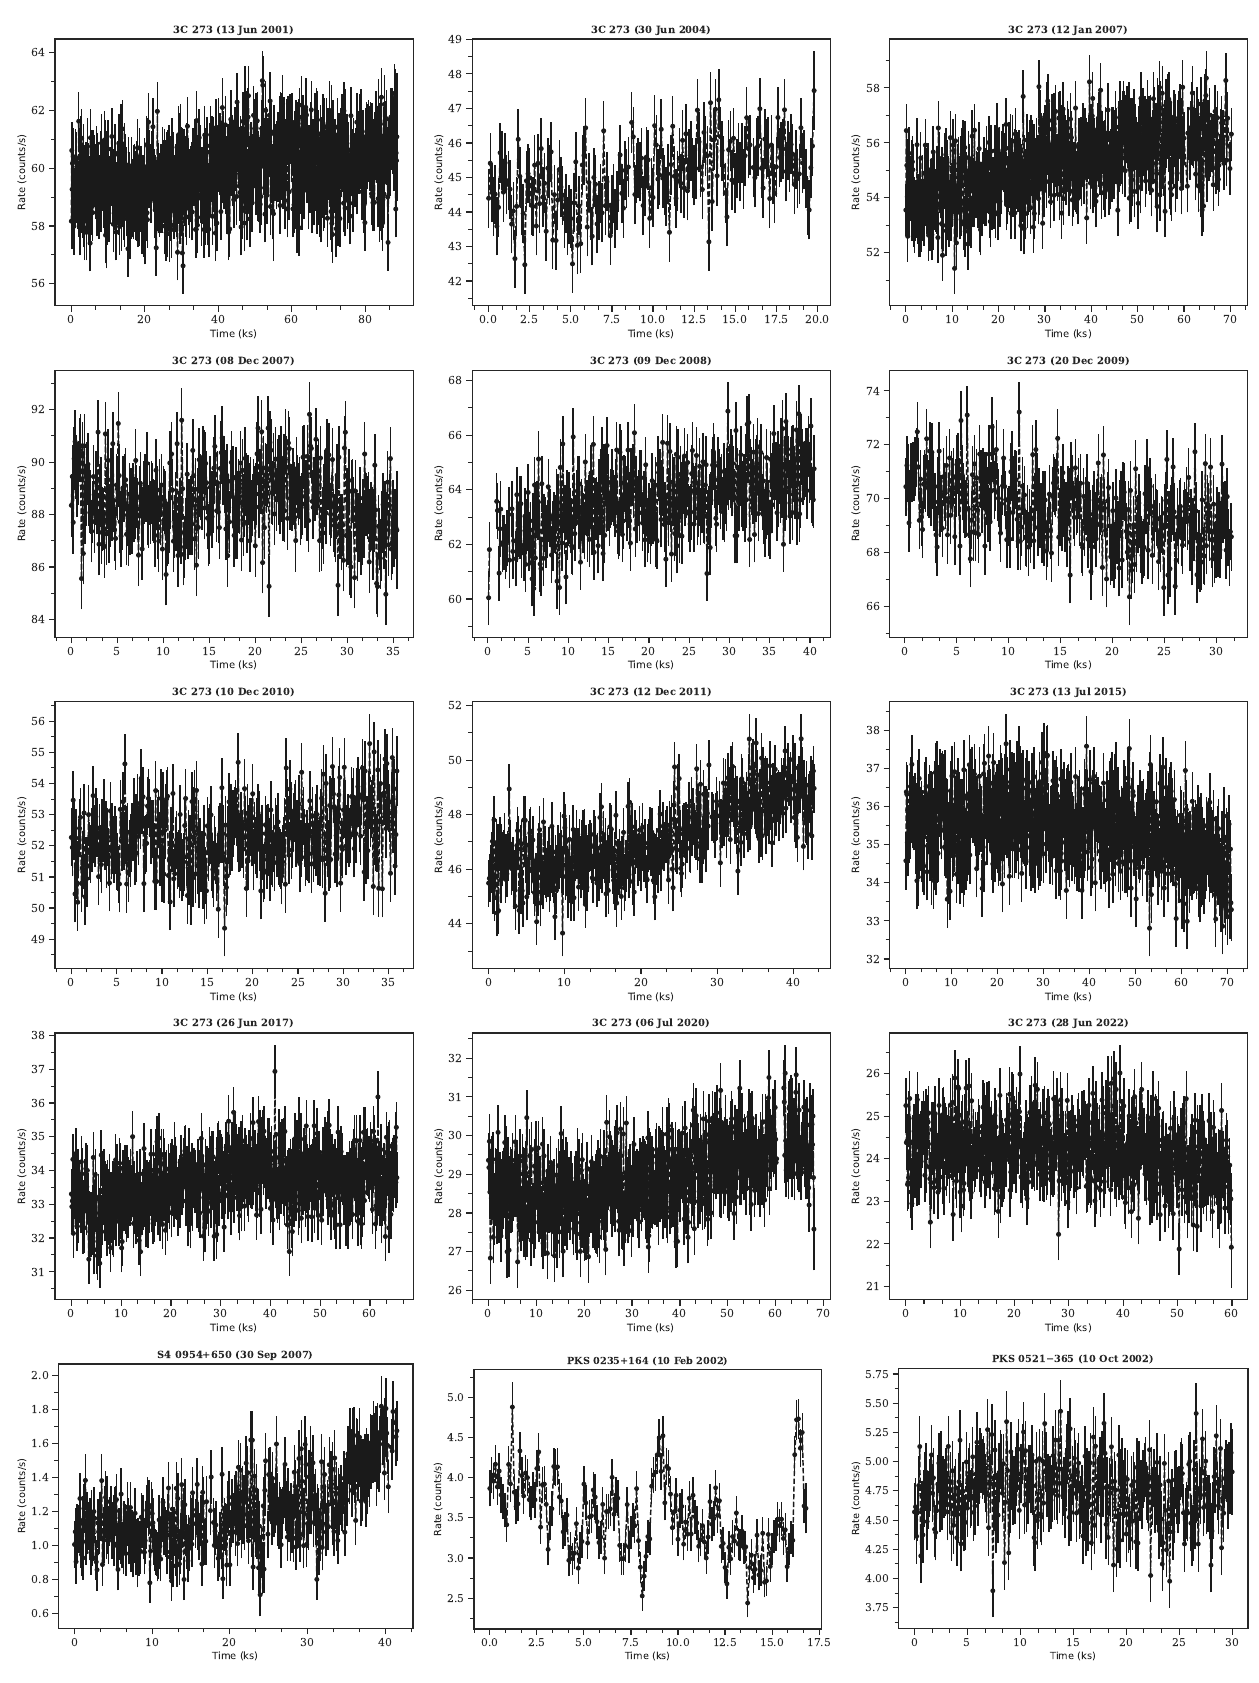
Figure 1. Light curves of XMM-Newton observations of blazars with a time binning of 100